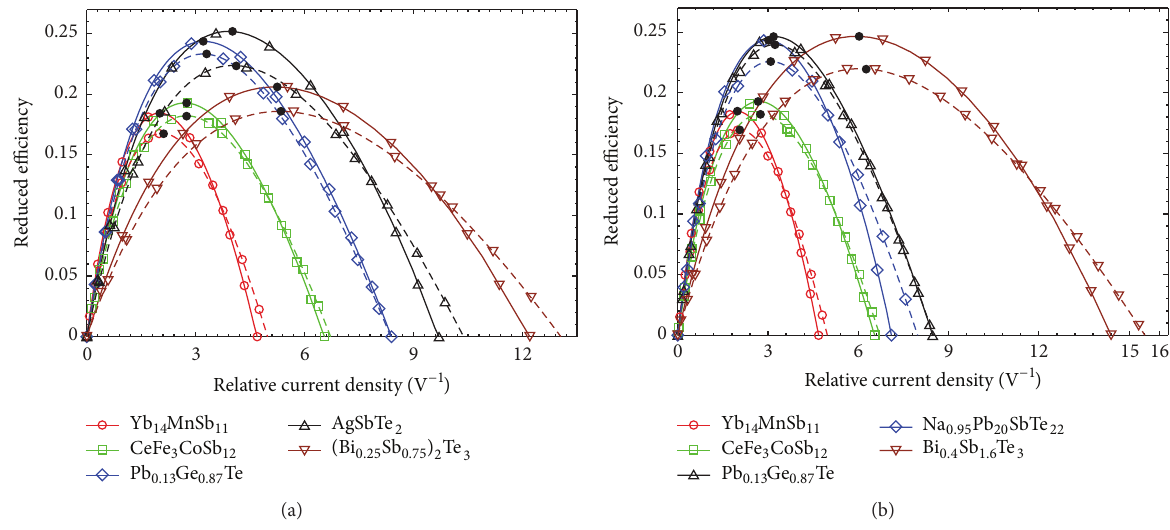
) (relative current density at 𝑇 ) for the materials used in (a) 𝑝 1-leg and (b) 𝑝 2-leg. The av av